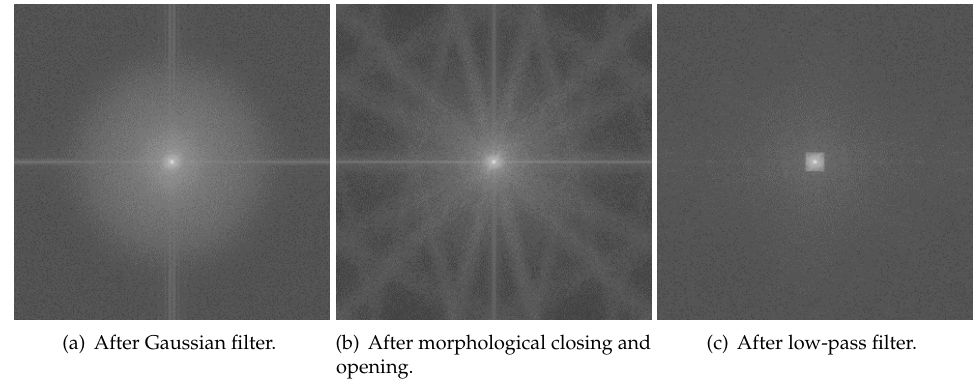
Figure 14. Frequency domain image after each process.